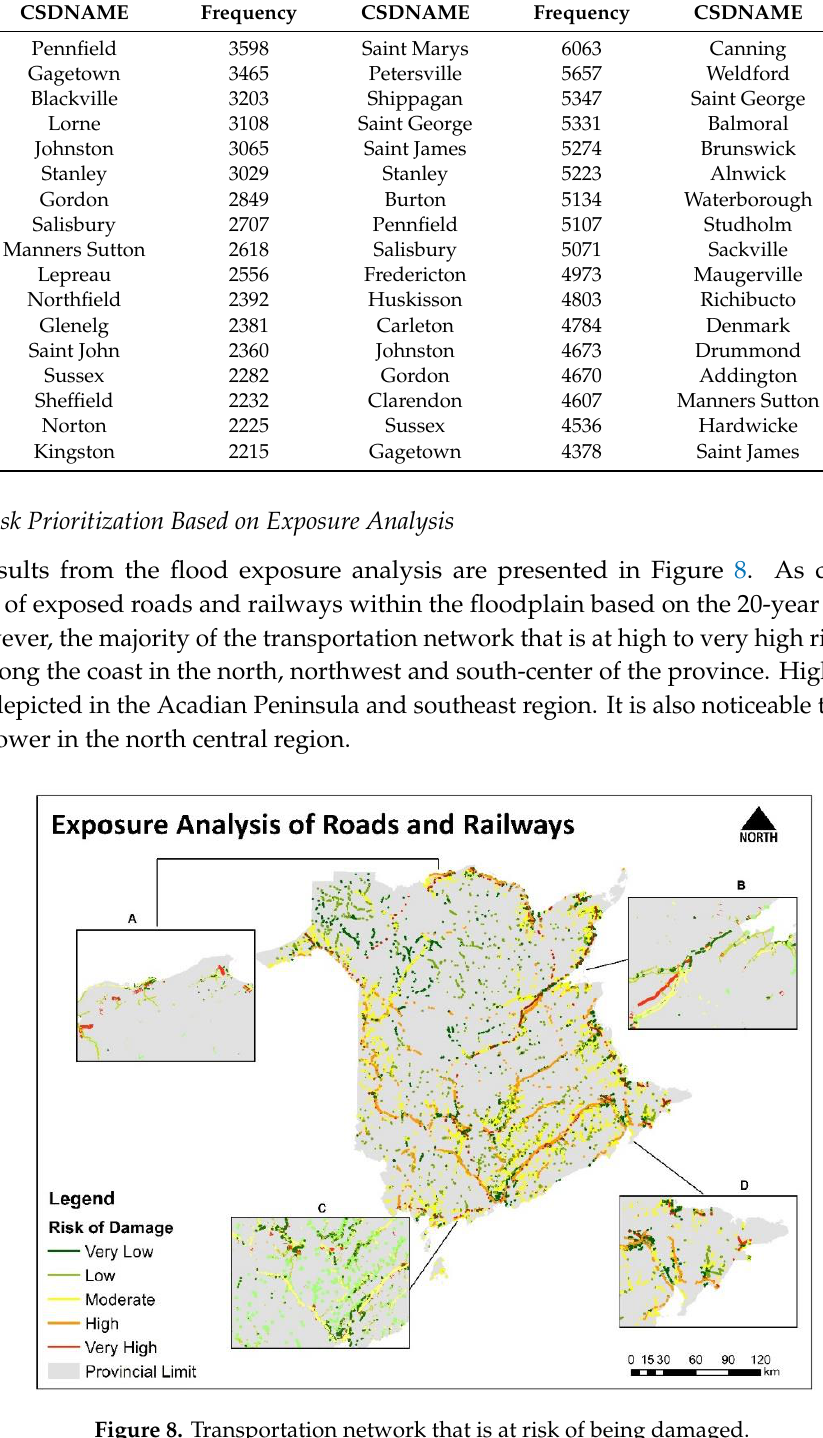
Figure 8. Transportation network that is at risk of being damaged.